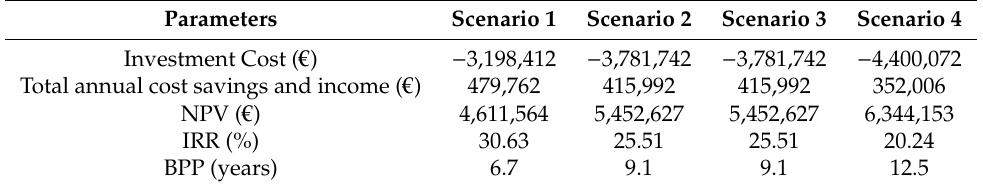
Table 5. Economic analysis results.